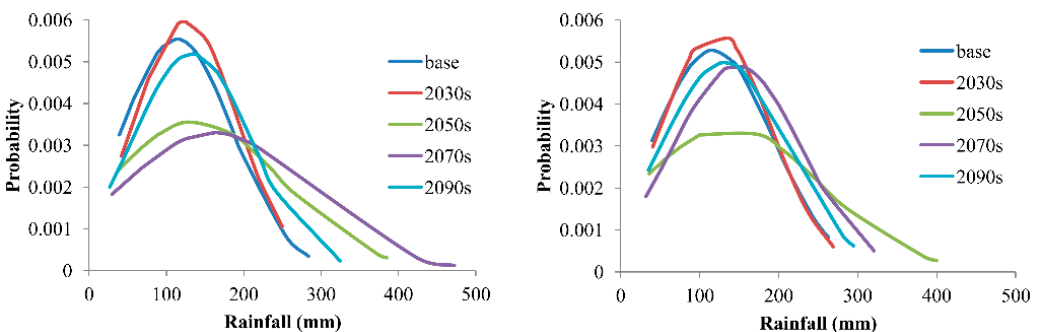
Figure 11. Typical PDFs of annual maximum rainfalls in two nearby grid cells in the central, coastal region of Bangladesh.